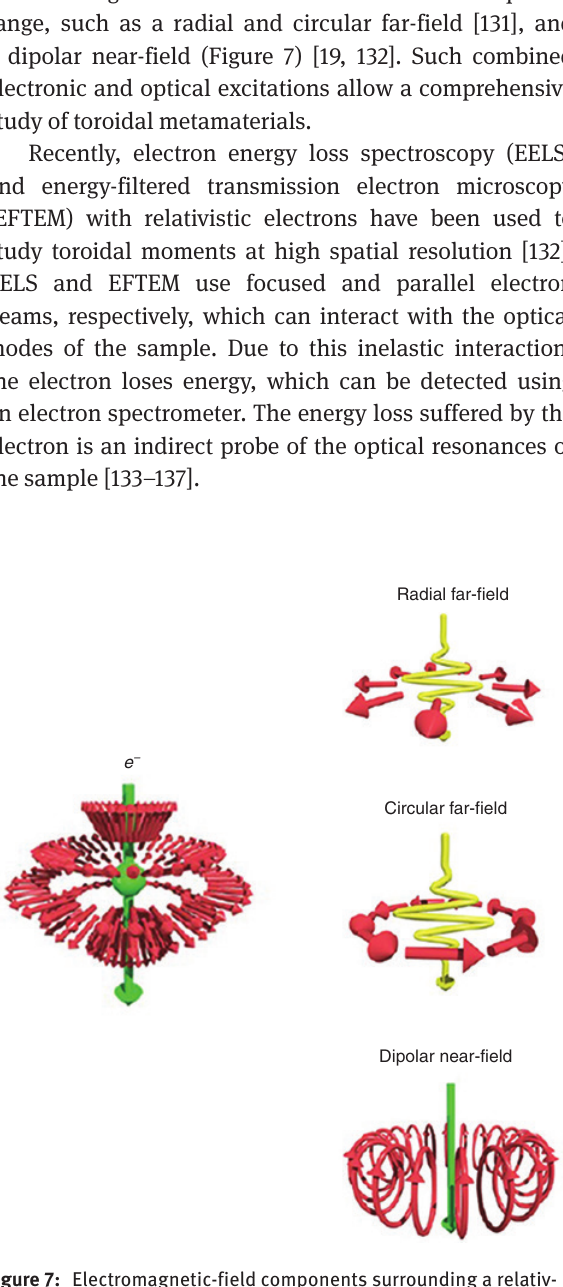
Figure 7: Electromagnetic-field components surrounding a relativ- istic electron. The excitation of relativistic electrons shares certain symmetric features with that of a radial and circular far-field, and of a dipolar near-field. Reprinted with permission from Ref.